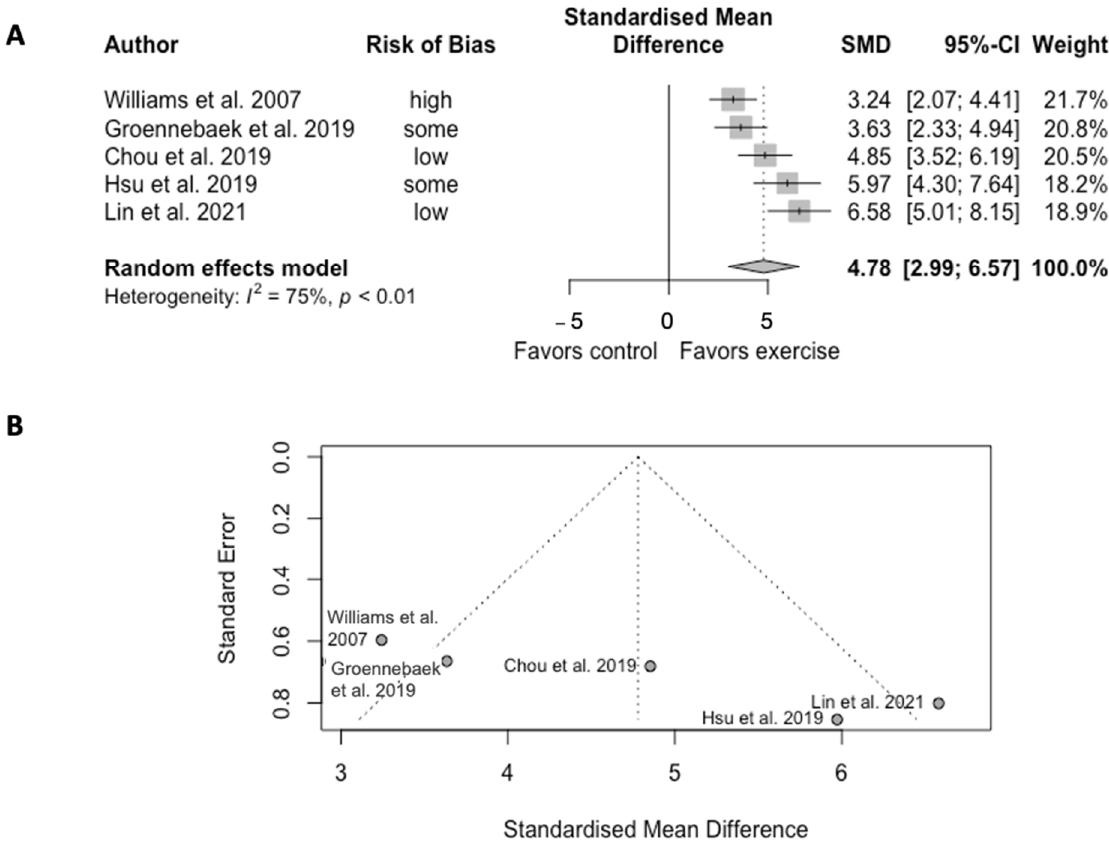
Figure 2. ( A ) Forest plot of effect sizes and 95% confidence intervals representing oxidative capacity, based on the random effects meta-analysis results. ( B ) Funnel plots of publication bias. Abbreviation: SMD, standardized mean difference. Williams et al. [38], Groennebaek et al. [32], Chou et al. [22], Hsu et al. [19], and Lin et al. [20].